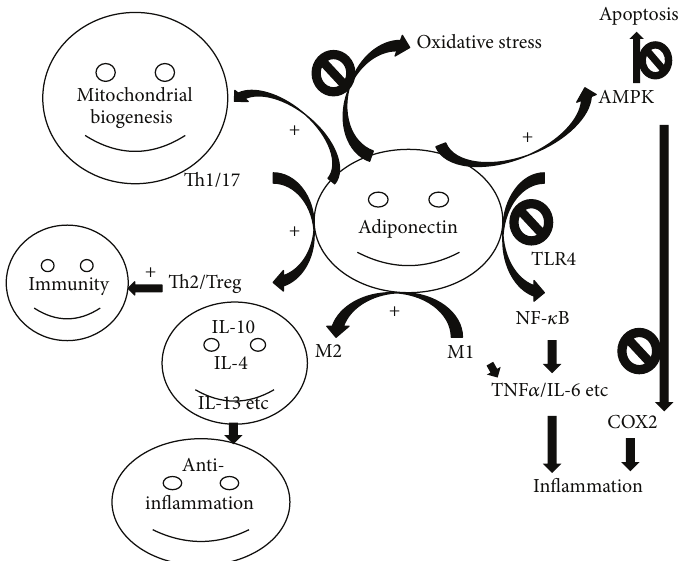
Figure 2: The major anti-inflammatory mechanism of adiponectin. Adiponectin polarizes macrophages from M1 to M2 and T helper cells from Th1 to Th2 and thus further increases immunity and has better anti-inflammatory effects. Furthermore, adiponectin activates AMPK and inhibits NF- 𝜅 B signaling pathways and thus inhibits inflammation. Additionally, adiponectin inhibits oxidative stress and stimulates mitochondrial biogenesis. Under obese state, the production of adiponectin is lower which is correlated with worse proinflammation and possible lung